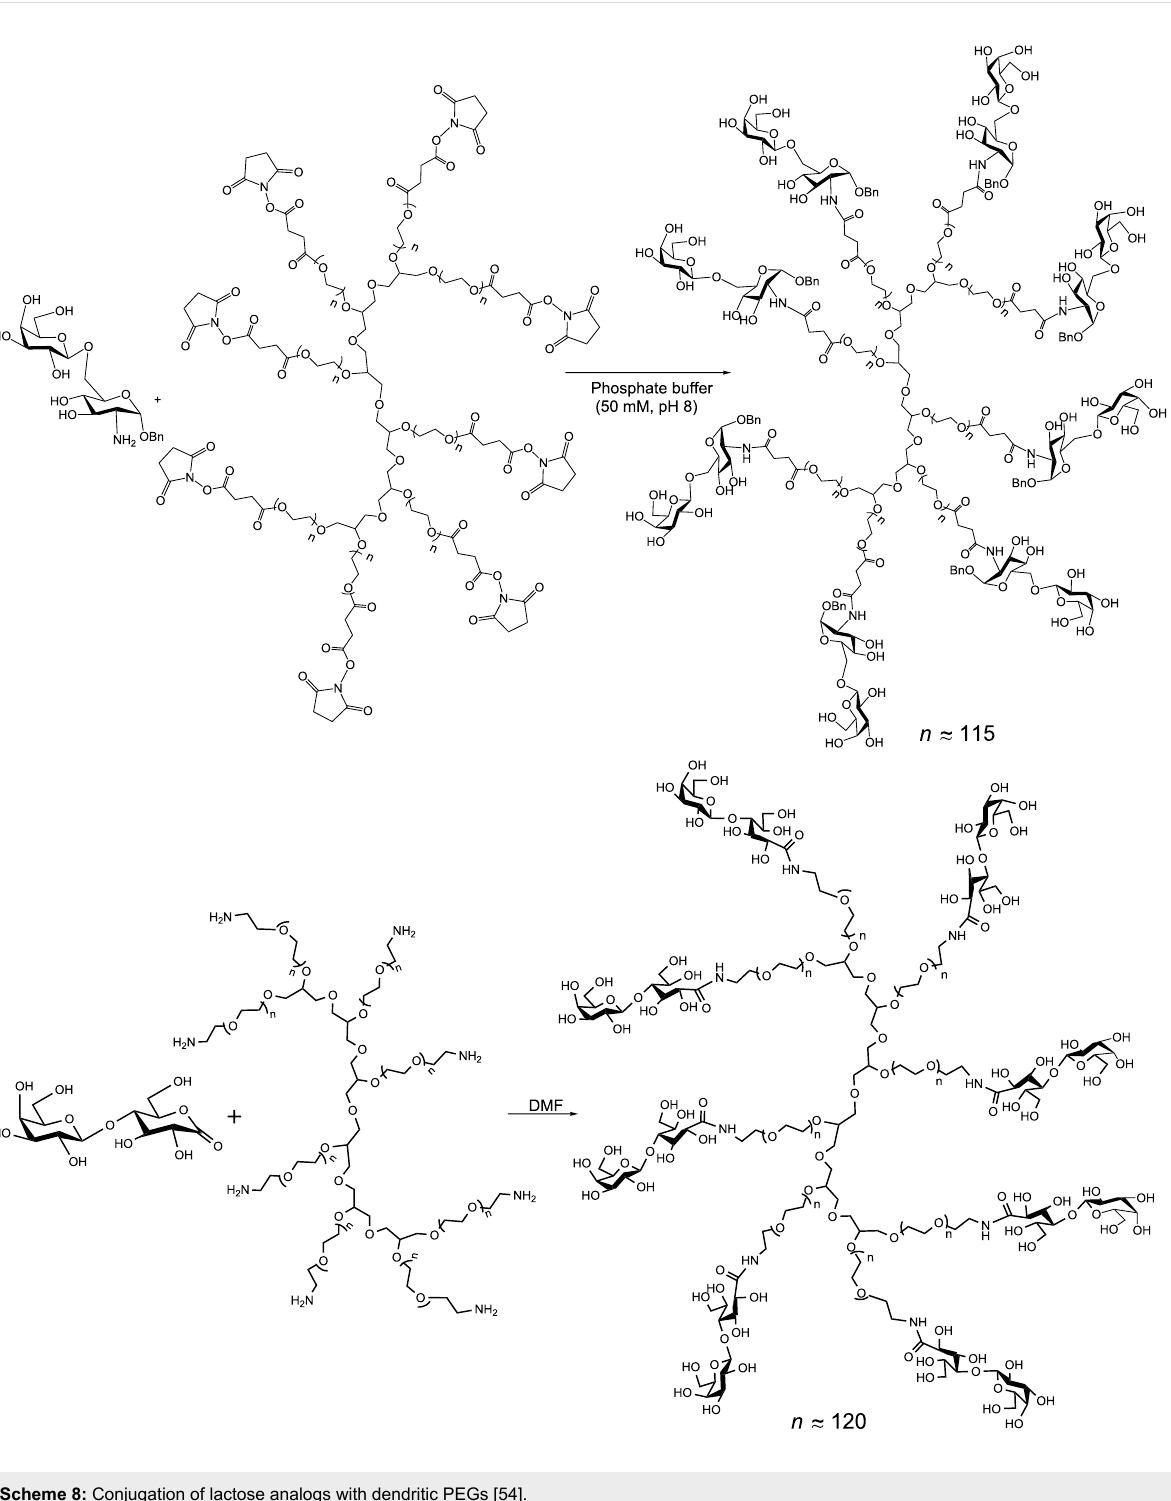
Scheme 8: Conjugation of lactose analogs with dendritic PEGs [54].